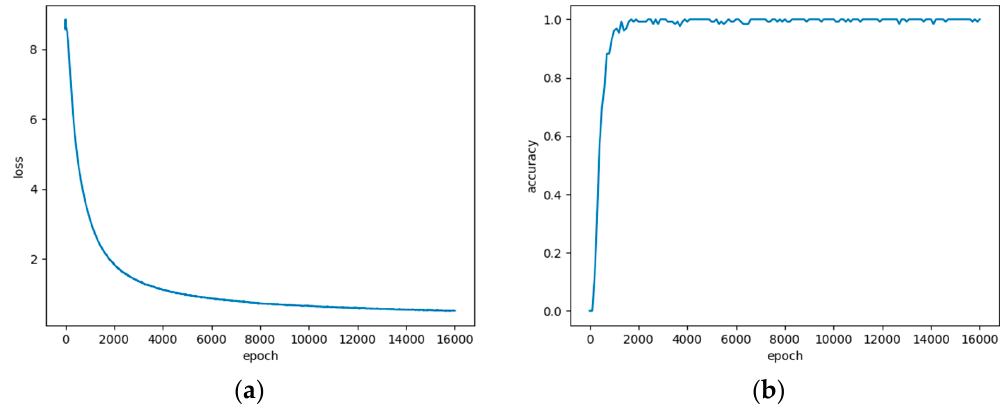
Figure 14. The structure of the dropout model. ( a ) Training set loss value: declining curve; ( b ) test set accuracy: rising curve.